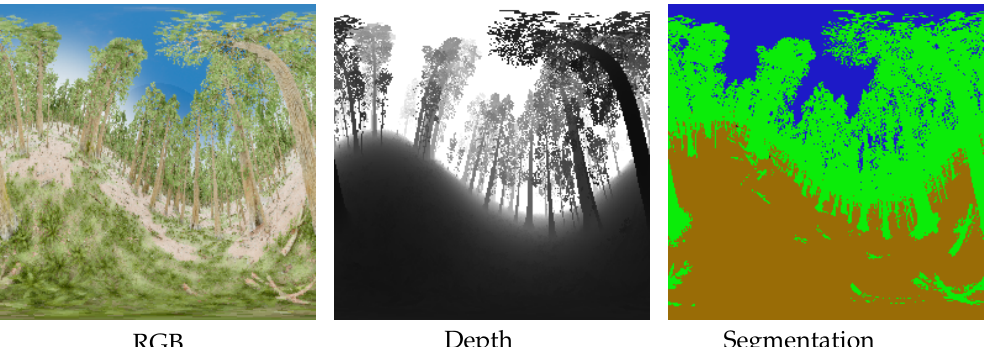
Figure 3. RWFOREST 256 × 256